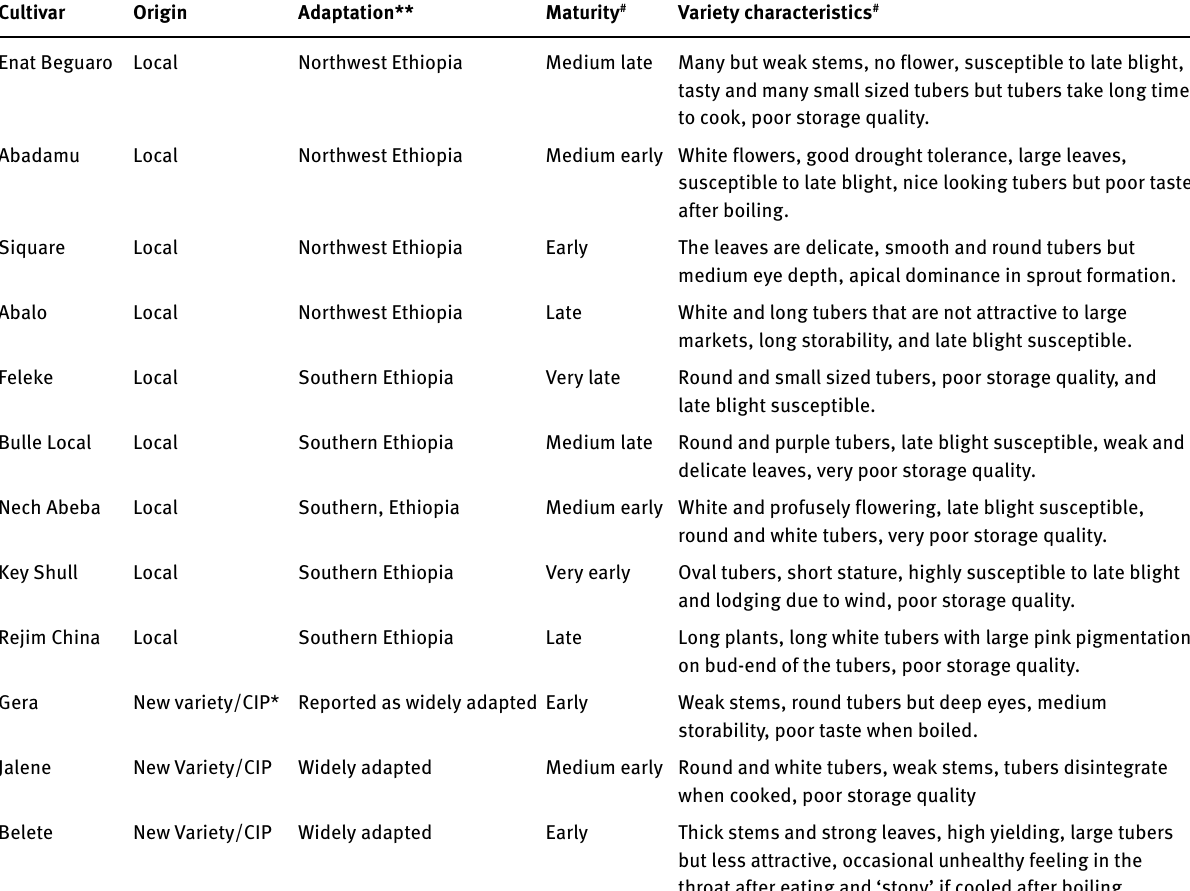
Table 1: Adaptation and characteristics of tested varieties